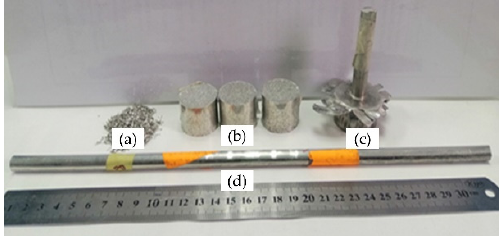
Figure 4. Recycle chips conversion; ( a ) aluminium chips; ( b ) compacted billet; ( c ) discarded extrudate; ( d ) extrudate billet.